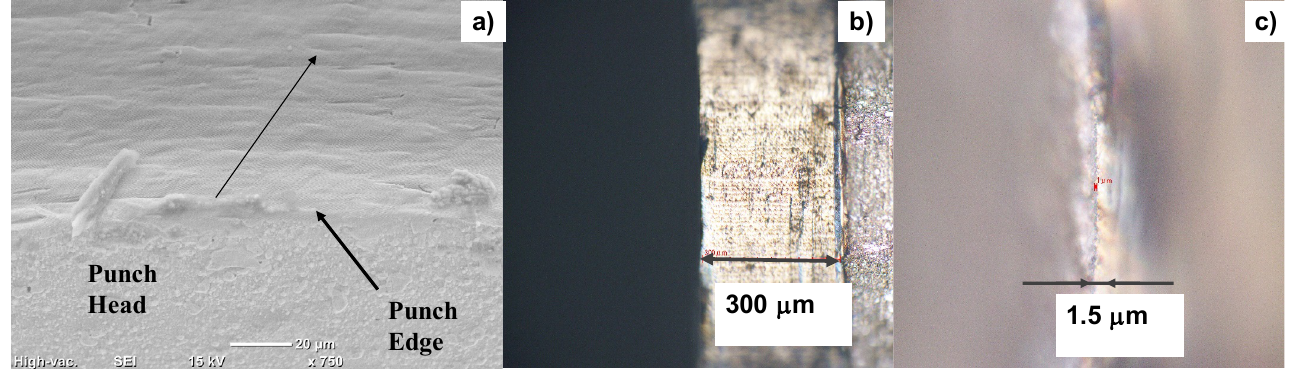
Figure 10. The laser-trimmed SKD11 punch. ( a ) SEM image on the nitrided SKD11 punch after femtosecond laser trimming, ( b ) laser-trimmed side surface of punch, and ( c ) the edge width of trimmed punch.